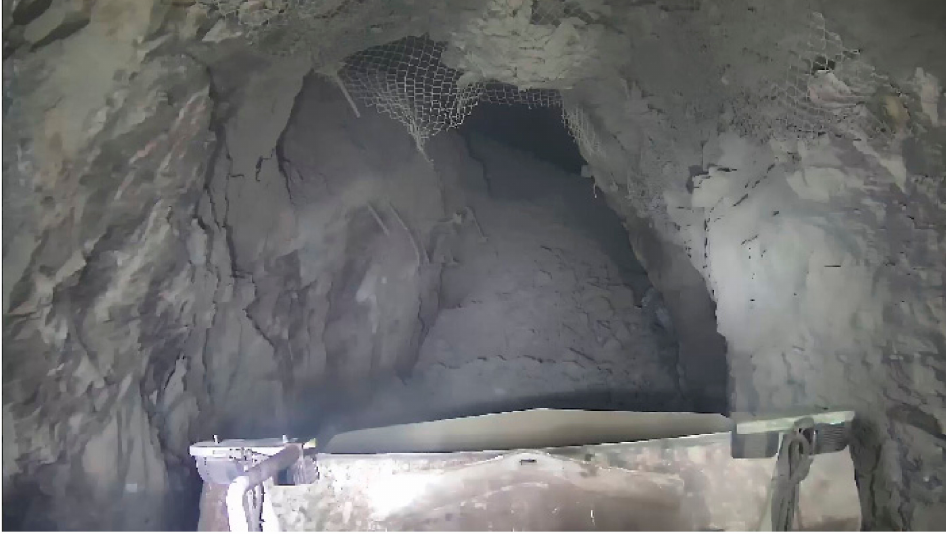
Figure 22. Operator’s point of view of the loading point used for onsite